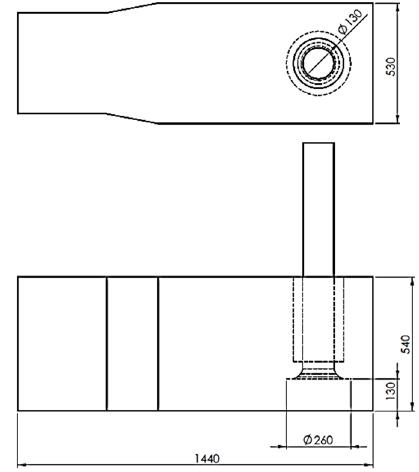
Figure 2. Pump sump model for numerical analysis.